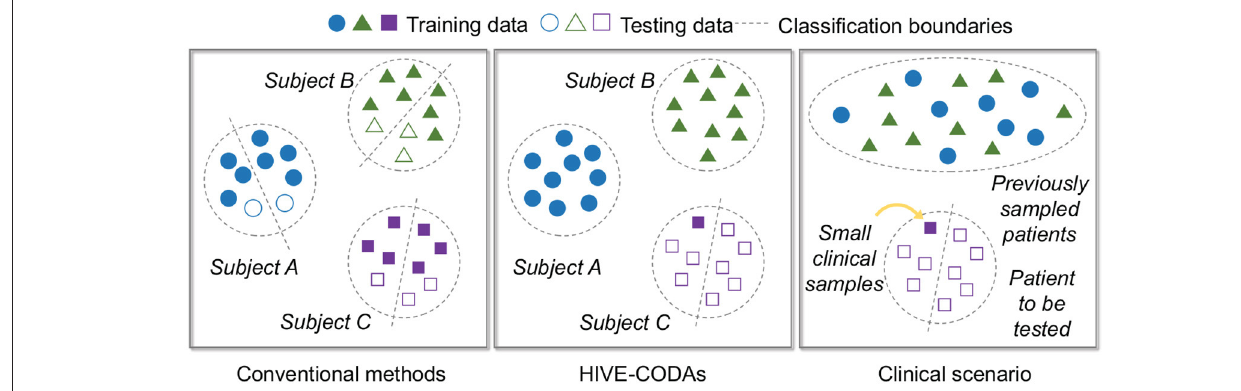
FIGURE 3 | Illustration of clinical situation simulation.